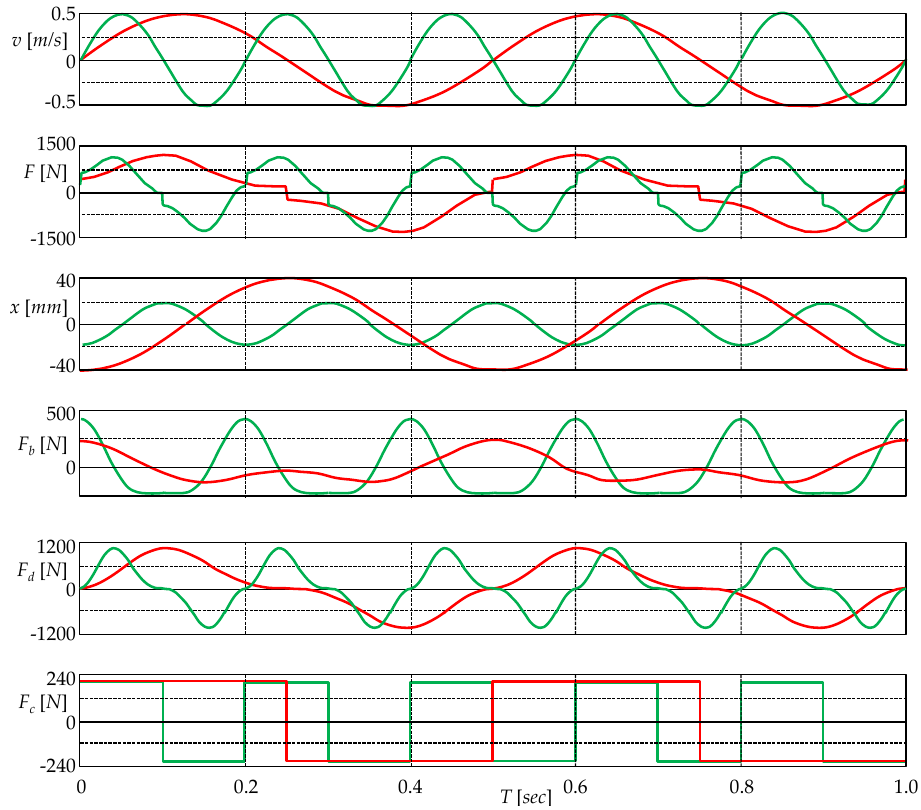
Figure 4. Waveforms of quantities during sinusoidal excitation of the device from Figure 2. From top to bottom: piston velocity v relative to the cylinder, total force F between the piston and cylinder, instantaneous position x of the piston center relative to the cylinder center, inertial force F b of the fluid as a derivative of the momentum (15) with respect to time, viscous friction force F d (20) in the fluid, Coulomb friction force F c (22).